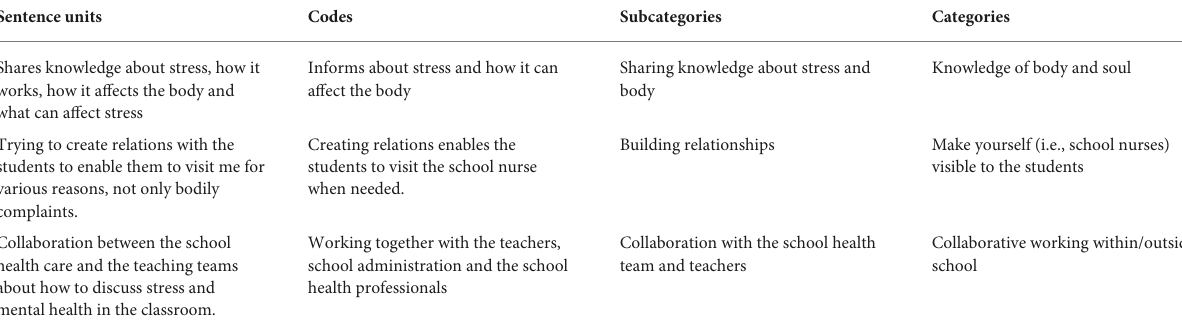
TABLE 1 Overview of the sentence units, codes, subcategories, and